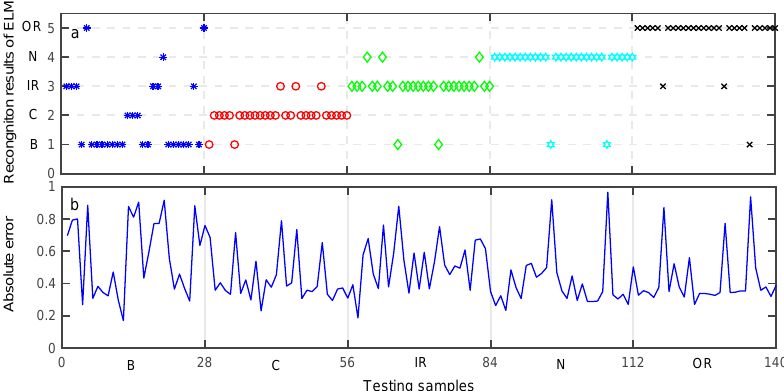
Figure 11. Preliminary diagnosis of extreme learning machine (ELM). ( a ) Recognition results. ( b ) Absolute error of the proposed approach output with respect to the desired output. Table 9. Classification accuracy of ELM (%).